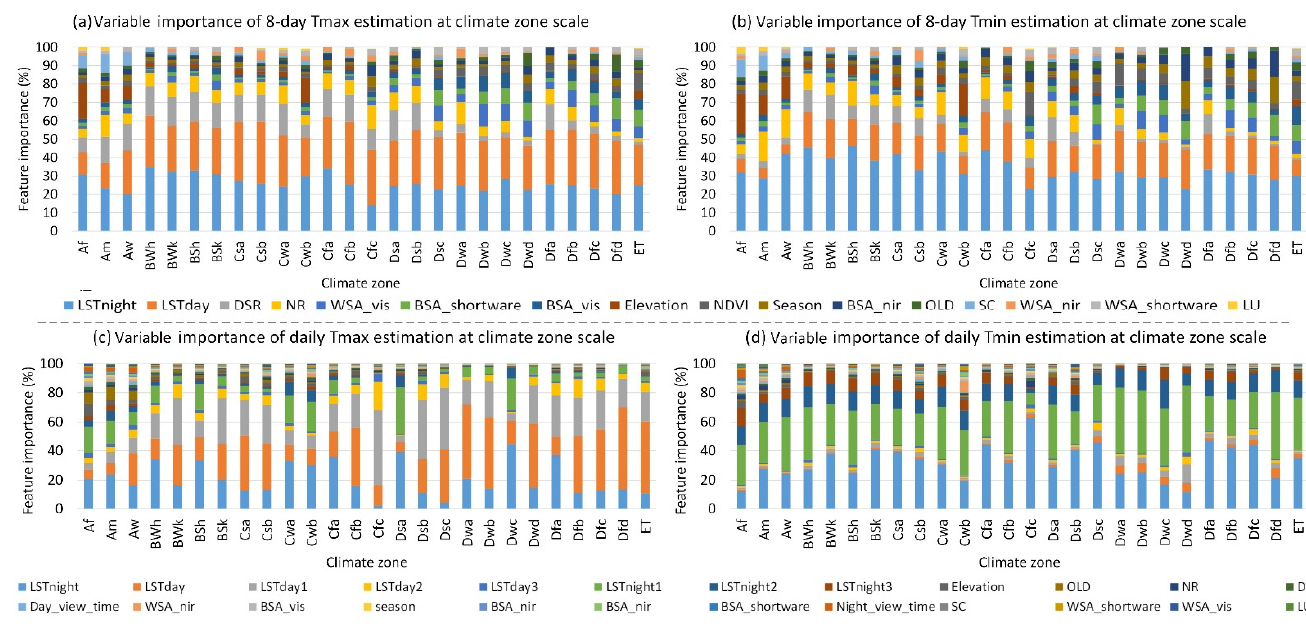
Figure 9. Variable importance (%) of 8-day tmax ( a ), 8-day Tmin ( b ), daily Tmax ( c ), and daily Tmin ( d ) in spatial experiments on a climate zone scale.